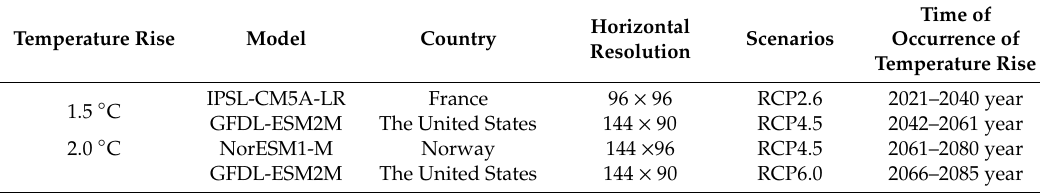
Table 6. Basic characteristics of the selected global climate model